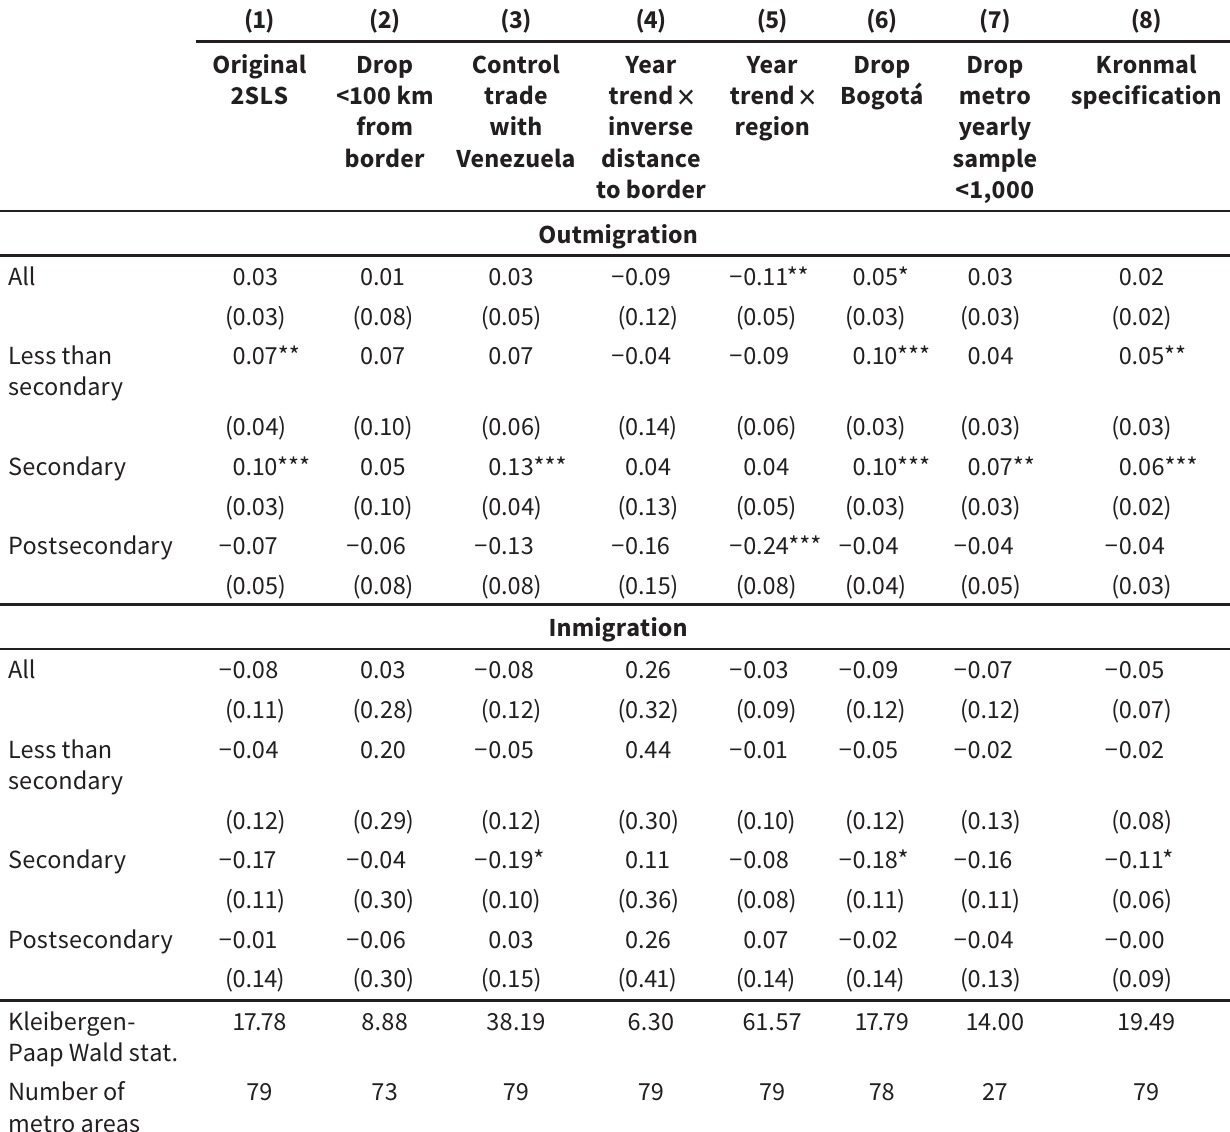
Table A9 Robustness of 2SLS effects on native internal migration